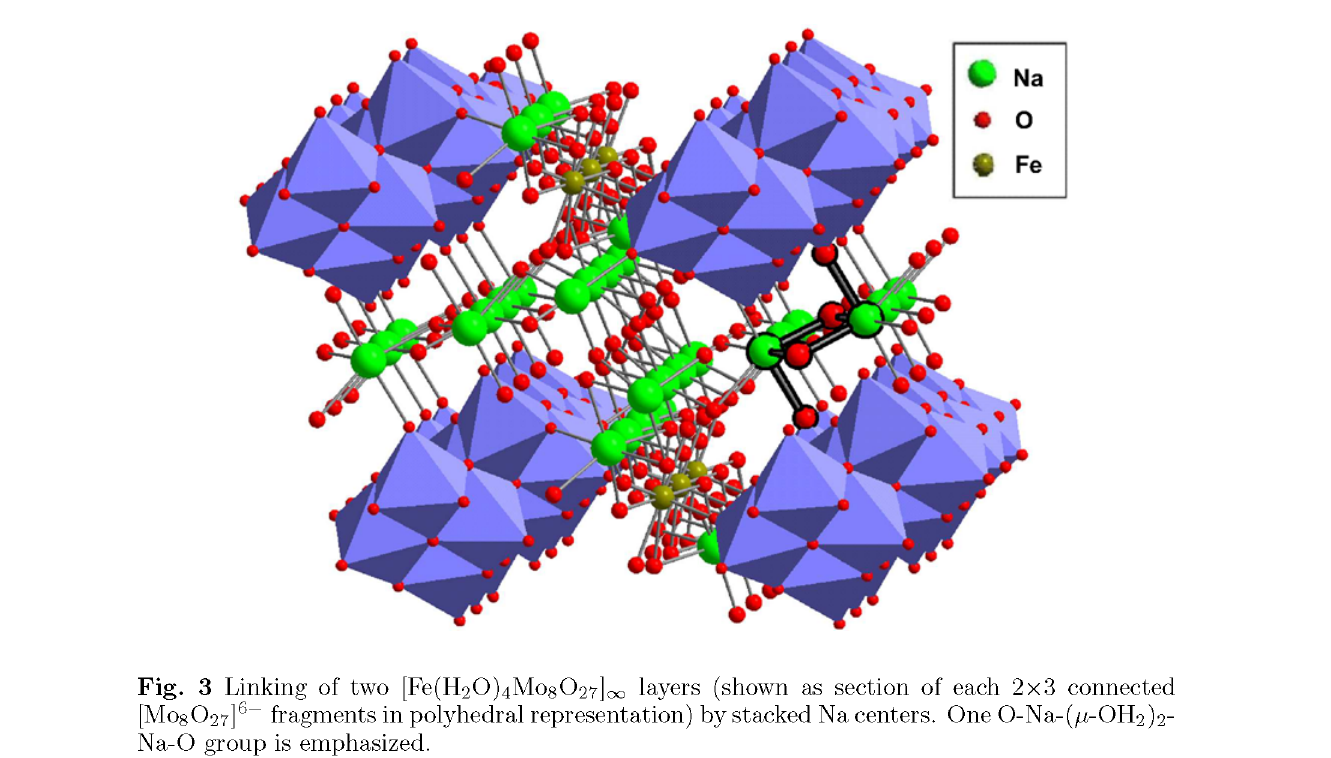
Fig. 3 Linking of two [Fe(H20)4MosO27]c~ layers (shown as section of each 2x3 connected [MosO27] 6 fragments in polyhedral representation) by stacked Na centers. One O-Na-(y-OH2)2- Na-O group is